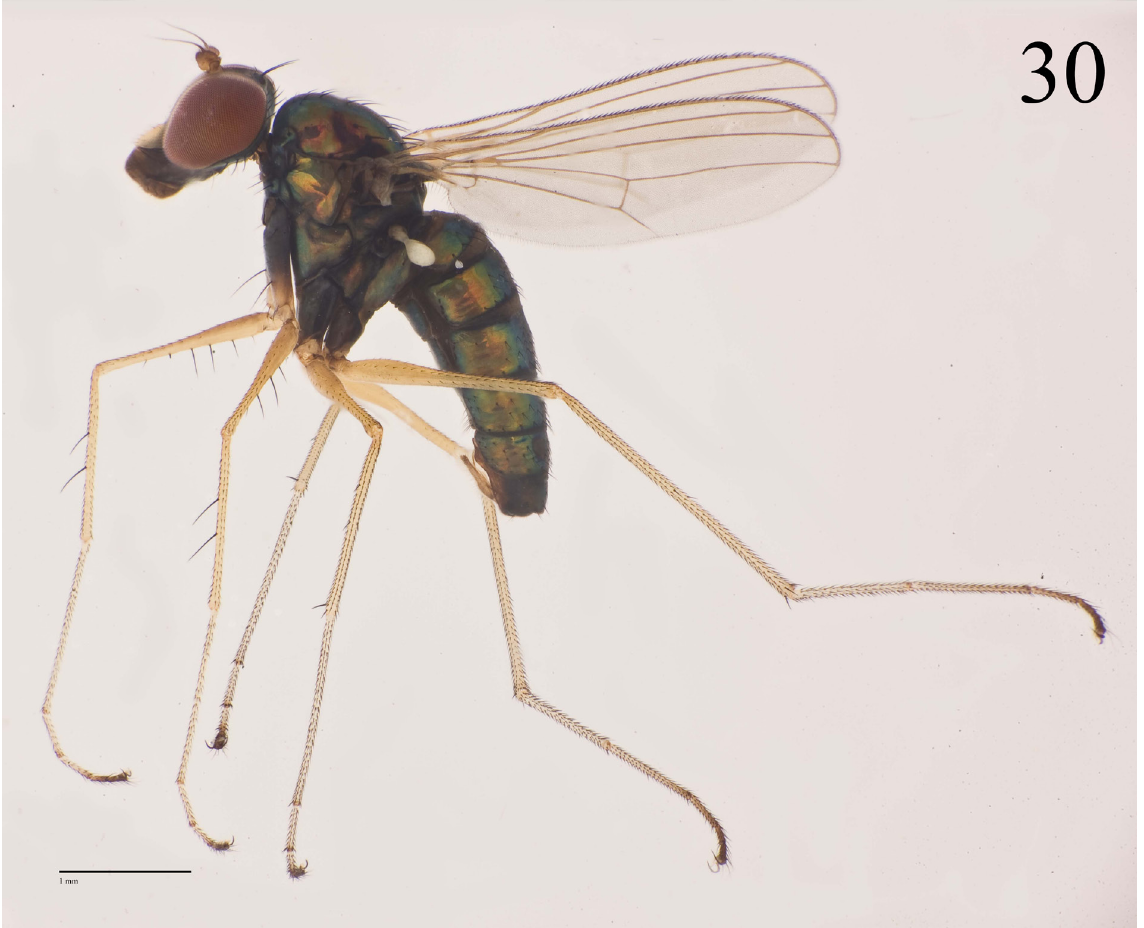
Fig. 30. Thinophilus spinatus sp. nov., ♂,